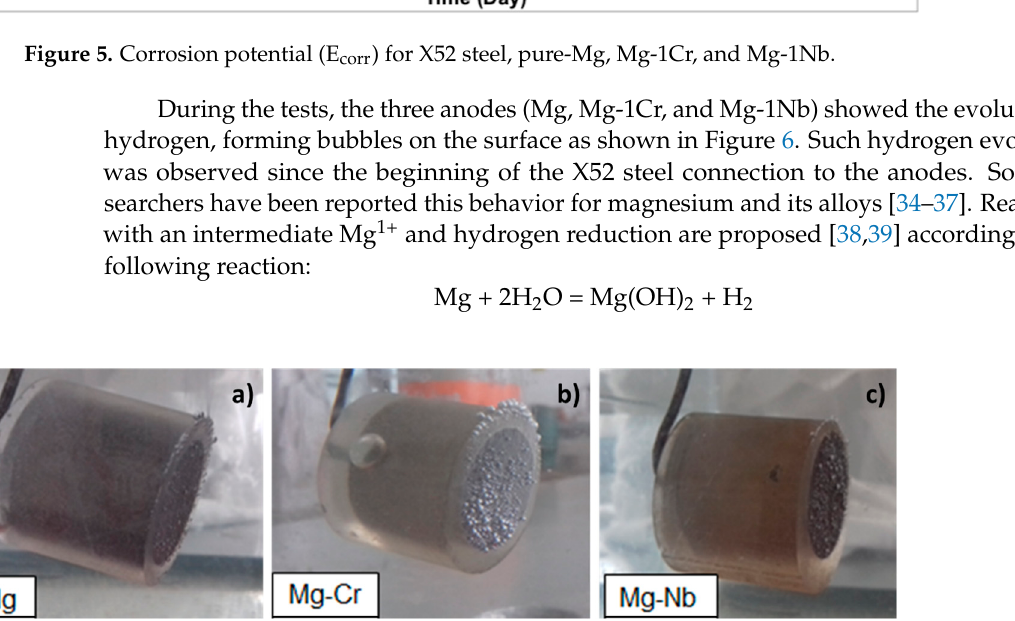
Figure 6. Hydrogen evolution at anodes electrically connected to X52 steel in seawater.